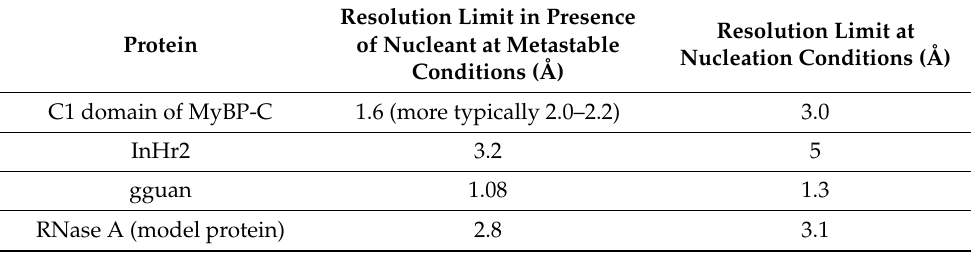
Table 2. Resolution limits of crystals grown with a porous nucleant in the metastable zone of conditions versus crystals grown in the absence of a nucleant in the spontaneous nucleation zone.